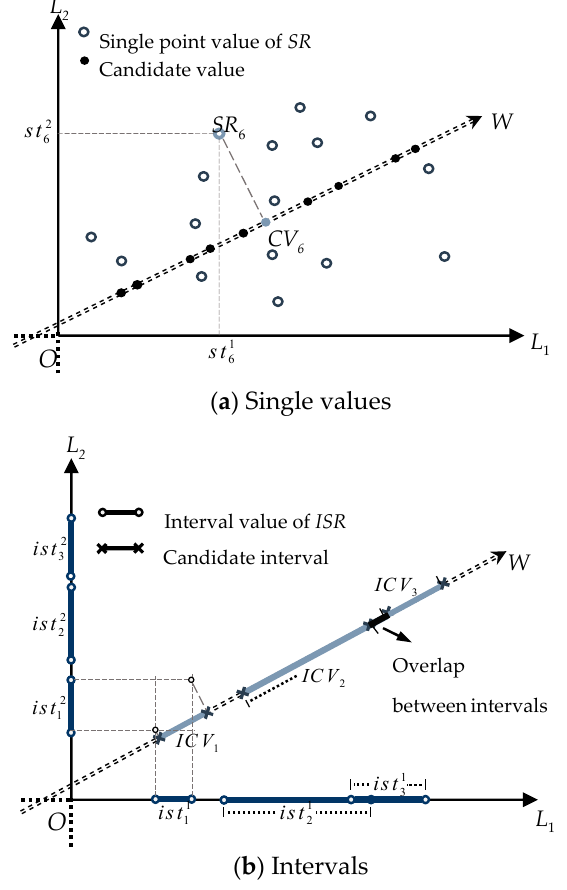
Figure 2. Schematic diagram of linear projection of rule dimensionality reducer.